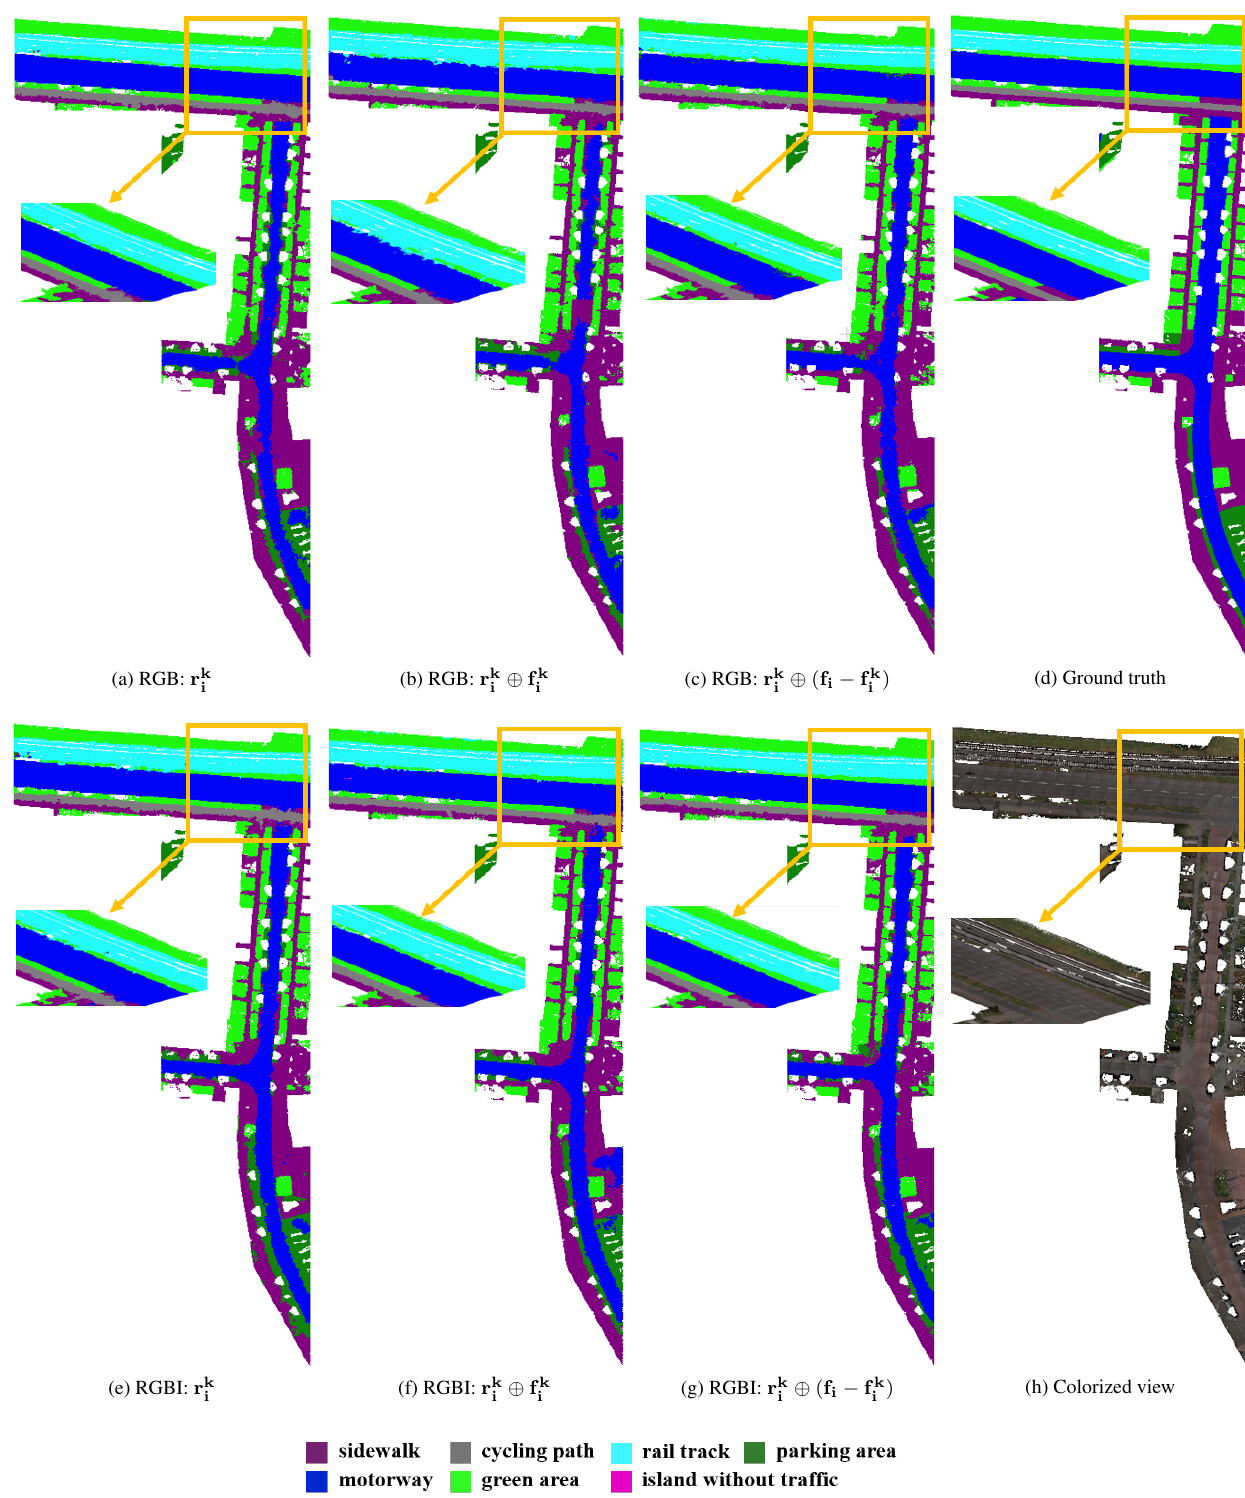
Figure 6. Comparison of road type classification results using different feature combinations to weigh the neighboring